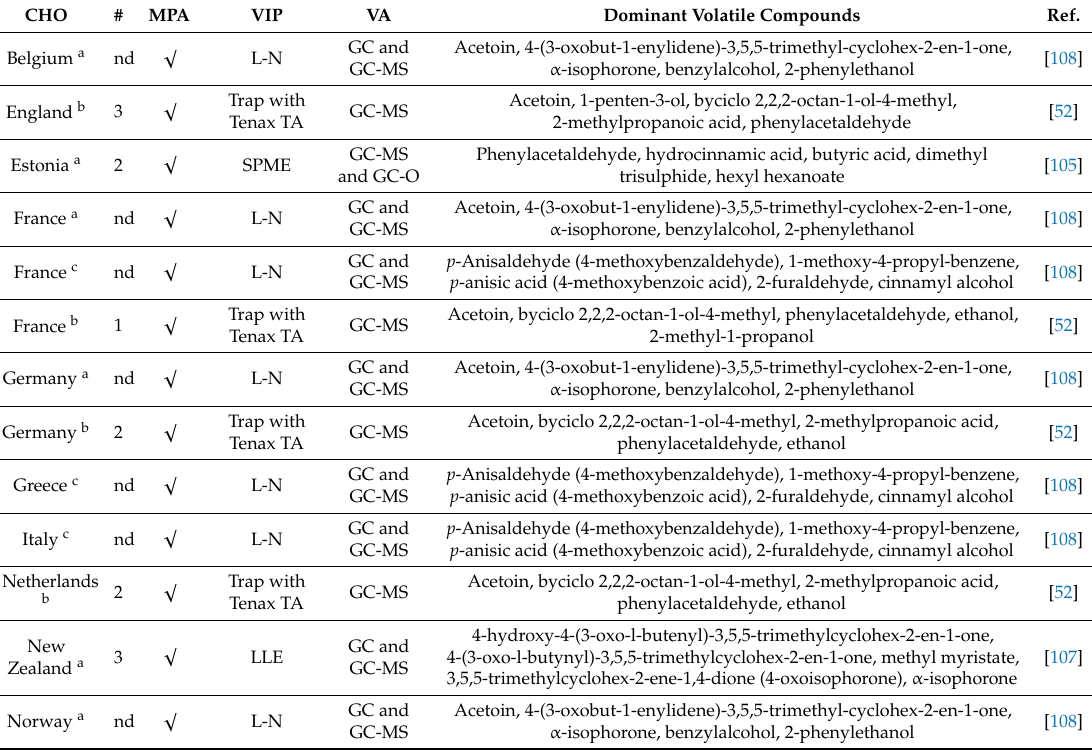
Table 10. Heather honey’s main volatiles, with reference to the country of origin, number of samples, isolation and analysis procedures and five main volatile components. Unless otherwise specified, the honeybee type was A. mellifera